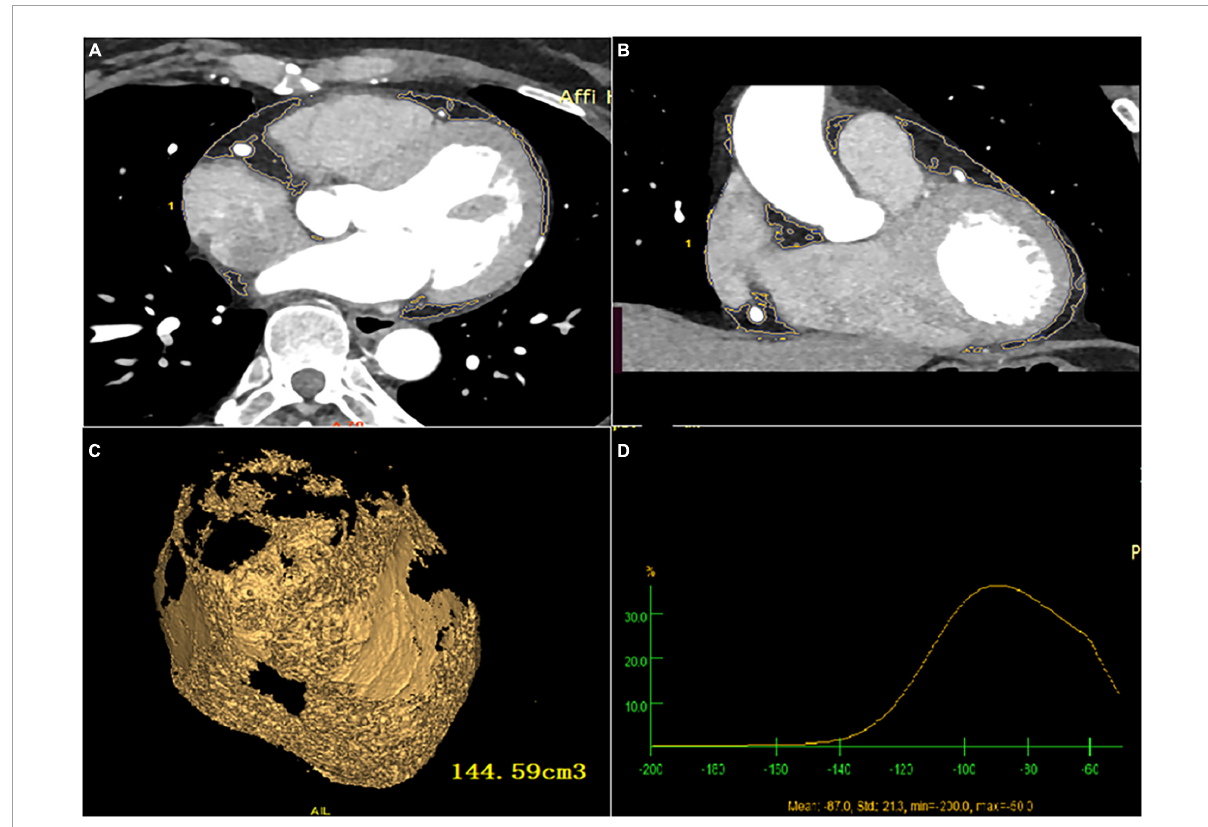
FIGURE2 Total EAT volume and attenuation calculated by post-processing software (A) cardiac axial map; (B) cardiac coronal map; (C) yellow area represents total EAT, and the volume is calculated by Volume software; (D) total EAT